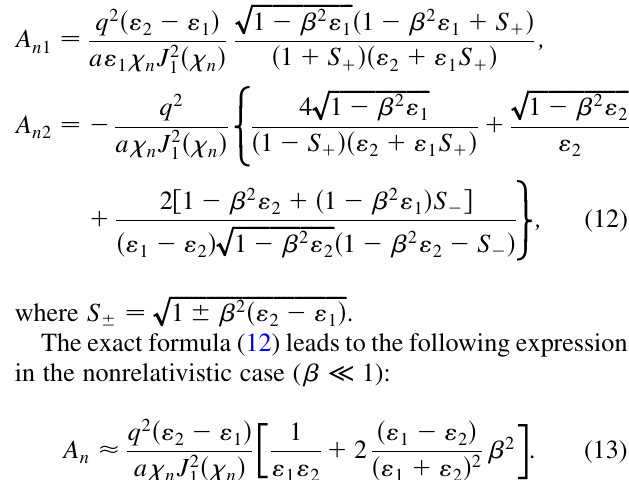
ffiffiffiffiffiffiffiffiffiffiffiffiffiffiffiffiffiffiffiffi p 1 (cid:3) (cid:1) 2 "